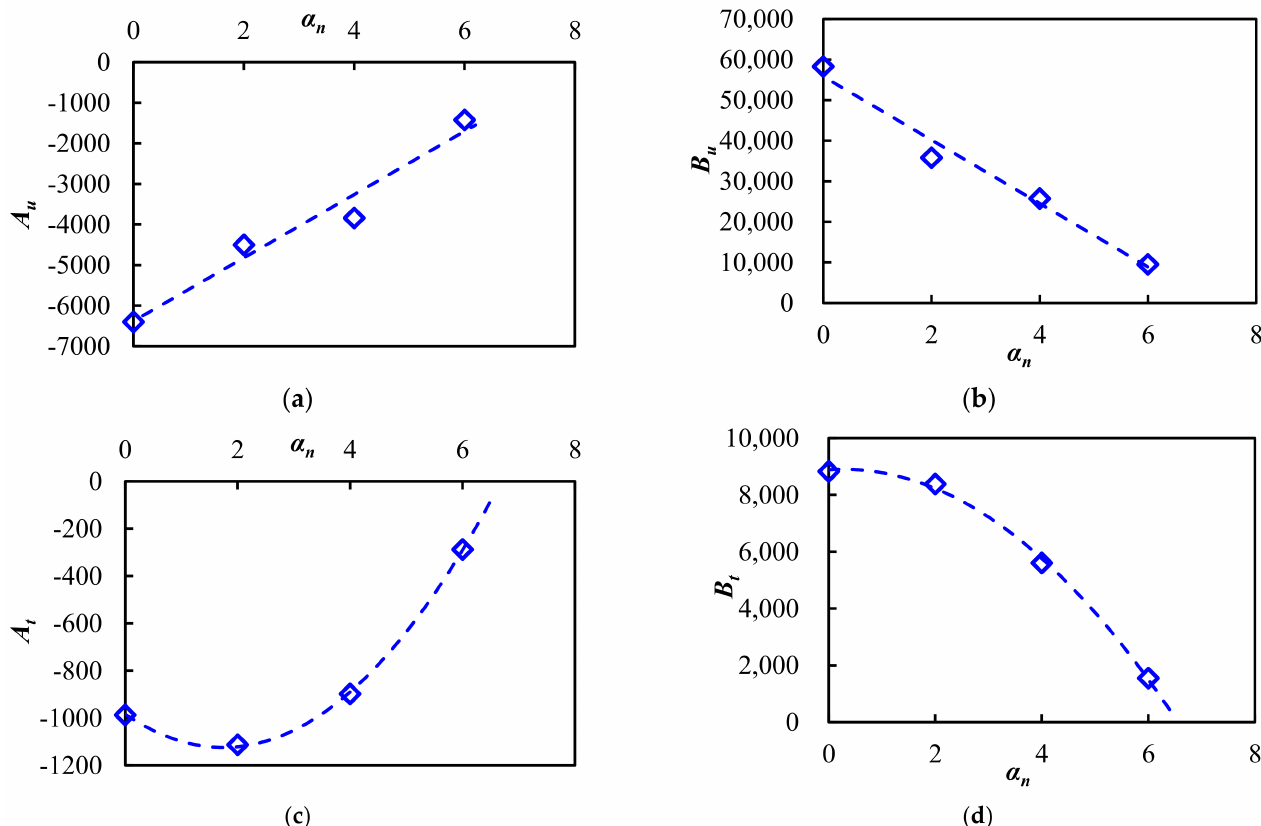
Figure 9. The relationship between A u ( t ) , B u ( t ) and nano-clay content α n : ( a ) The relationship between A u and α n ; ( b ) The relationship between B u and α n ; ( c ) The relationship between A t and α n ; ( d ) The relationship between B t and α n